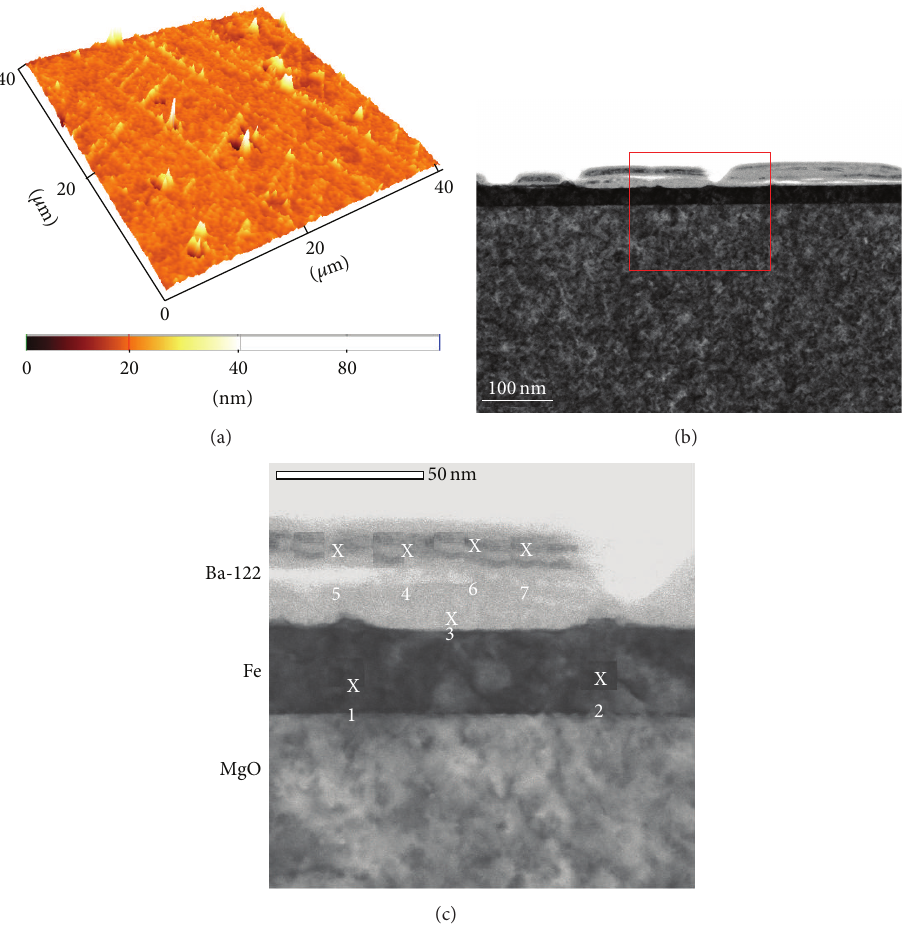
Figure 2: (a) AFM image (40 × 40 𝜇 m) of a Co-doped Ba-122 (100nm)/Fe thin film and (b) TEM image of the same sample. The TEM image within the red square in (b) is enlarged in